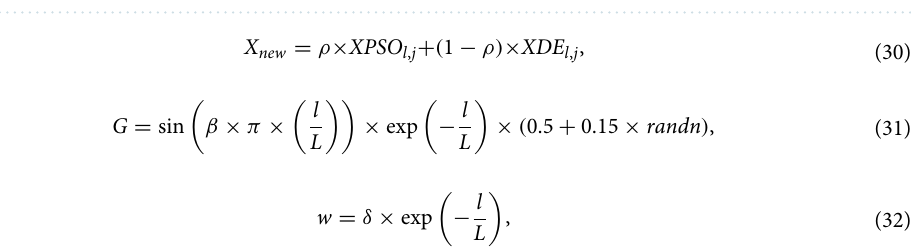
Figure 2. Flowchart of the proposed ANFIS-A-DEPSO